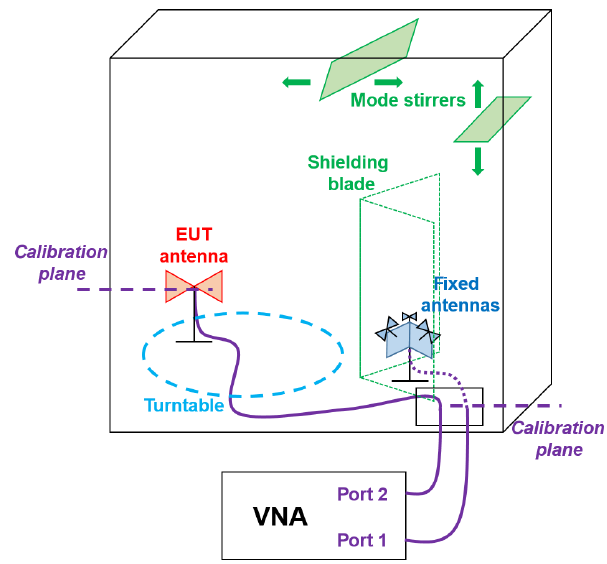
Figure 1. Sketch of the measurement setup within the RC. Table 1. Antenna